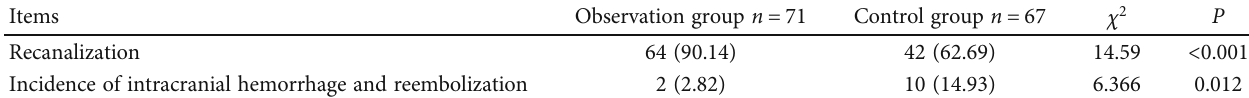
Table 4: Comparison of the incidence of vascular recanalization, intracranial hemorrhage, and reembolization between two groups after treatment.